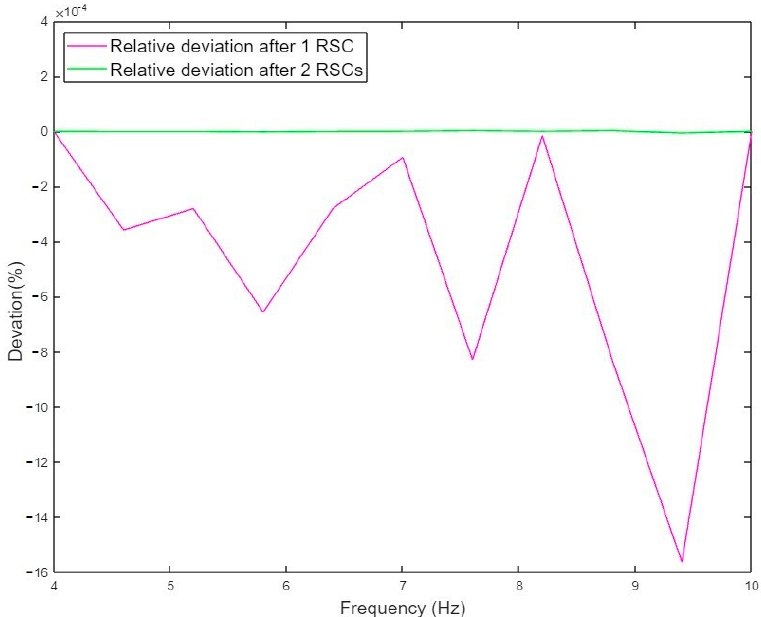
Figure 7. Improvement of measuring results using the iterative RSC. The above simulation results are based on noise-free signals or signals with high SNR. Yet there are always noise disturbances. Hence, the simulation results of signals with different SNRs were evaluated. Similarly, each signal group with the same SNR is divided into 10 equal parts with frequency ranging from 4 to 10 Hz. Thus, each group had 11 test points, which were then simulated under different usages of the RSC algorithm. The root- mean-square error (RMSE) analysis was performed for each group of measurements; con- sidering the randomness of the noise, each group was also simulated 10 times. Afterward, the RMSE values of the 10 different measurement groups were averaged. Furthermore, the asynchronous factor’s impact on the frequency measurement’s deviation without self- correction of the DFS algorithm signals was investigated under different SNRs. The sim- ulation results are shown in Table 2. Table 2. Simulation results of signals with different SNR in MATLAB.